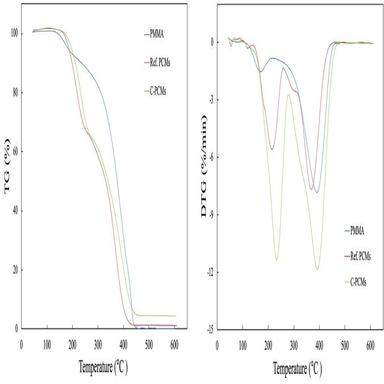
TGA curves of PCMs.